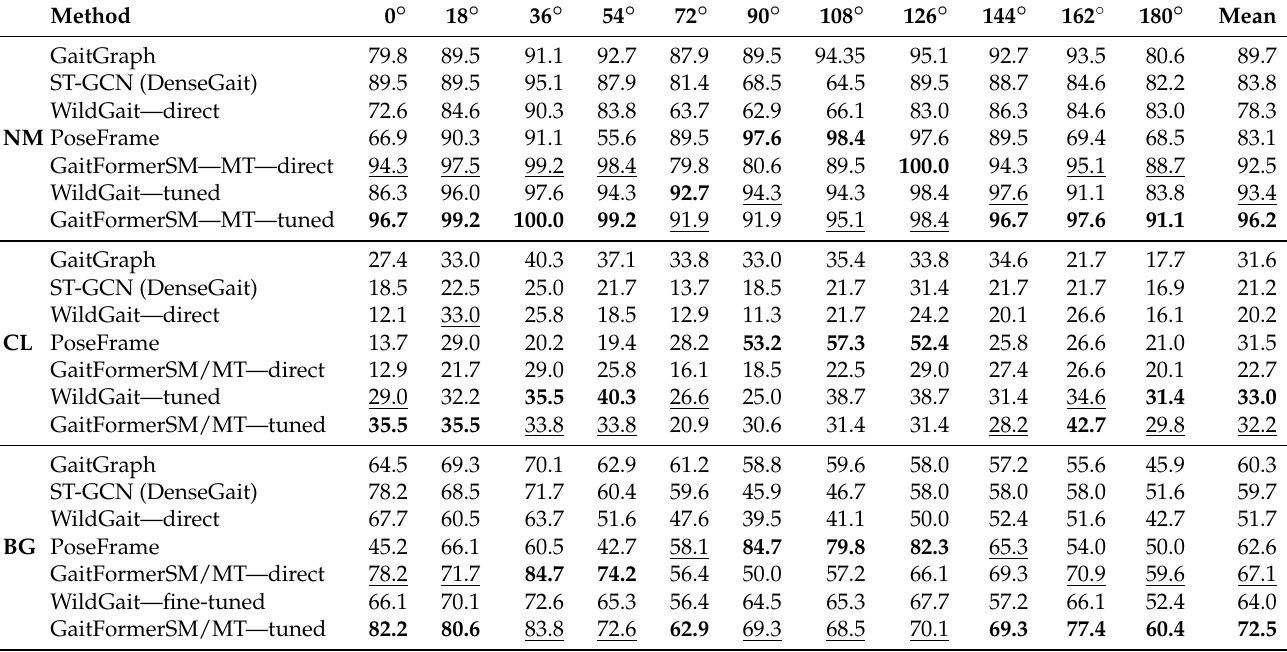
Table 4. GaitFormer comparison to other skeleton-based gait recognition methods on CASIA-B dataset. In all methods the gallery set contains all viewpoints except the proble angle. In bold and underline we highlight the best and second best results for a particular viewpoint and walking